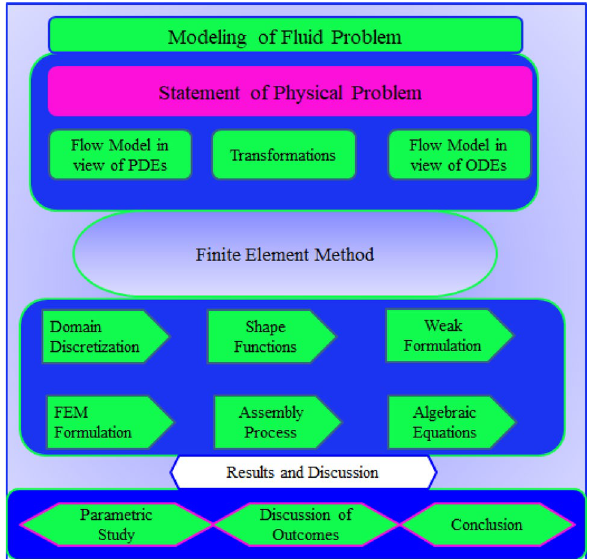
Figure 2. Work flow scheme of flow model.